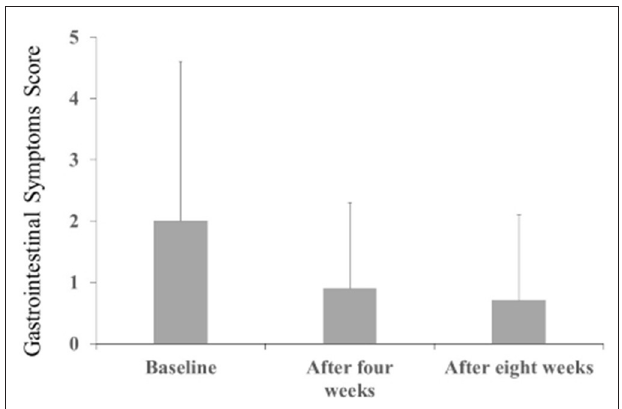
FIGURE 4 | The effects of YKSCH on Gastrointestinal Symptoms ( n = 28). Data were gastrointestinal symptoms scores (means ± SD and ranges) after YKSCH administration. Four cases with missing data were dropped from the analysis. Post hoc Tukey’s HSD tests were compared to